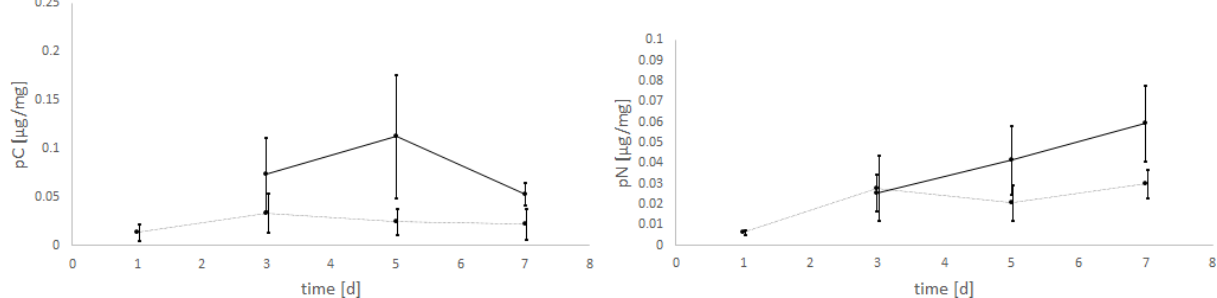
Figure 4. Effects of the light regime (light–dark cycle of 18 : 6h vs. continuous darkness) on the uptake of C (pC) and N (pN) from the green algae D. tertiolecta by E. excavatum after different feeding times at 20 ◦ C and a salinity of 20. The values of the “light experiments” are the same as used in Fig. 2.